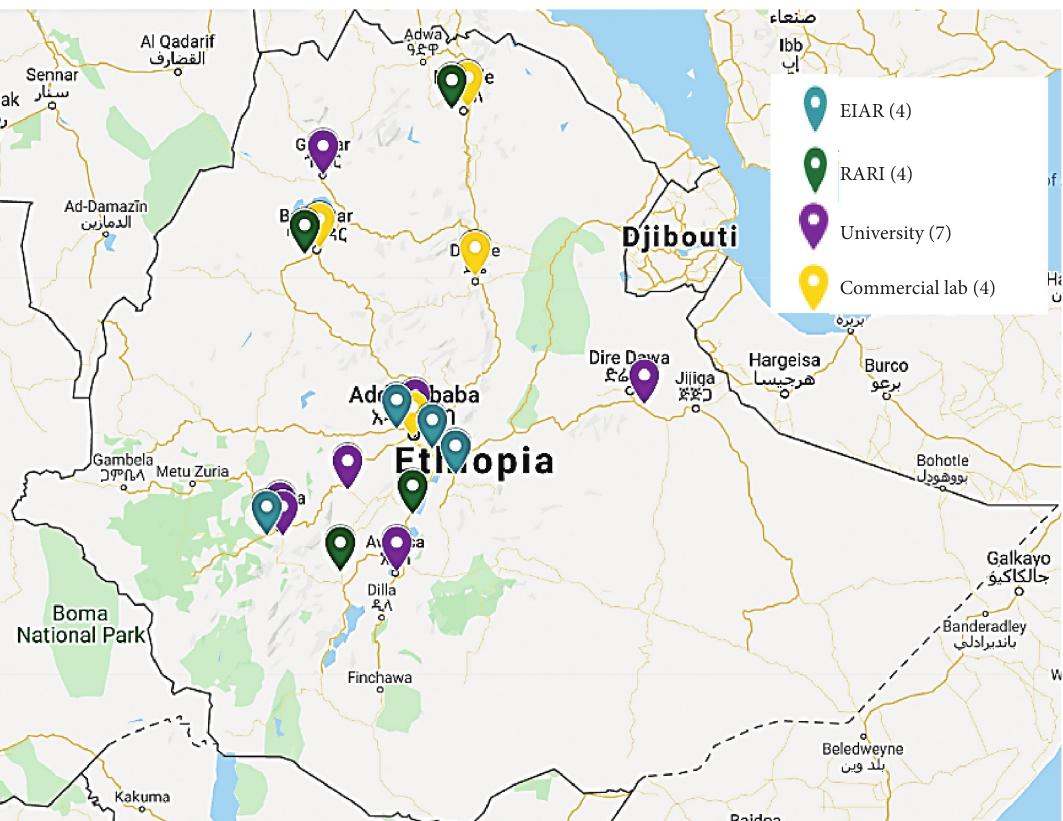
Figure 1: Location of plant tissue culture laboratories involved in the